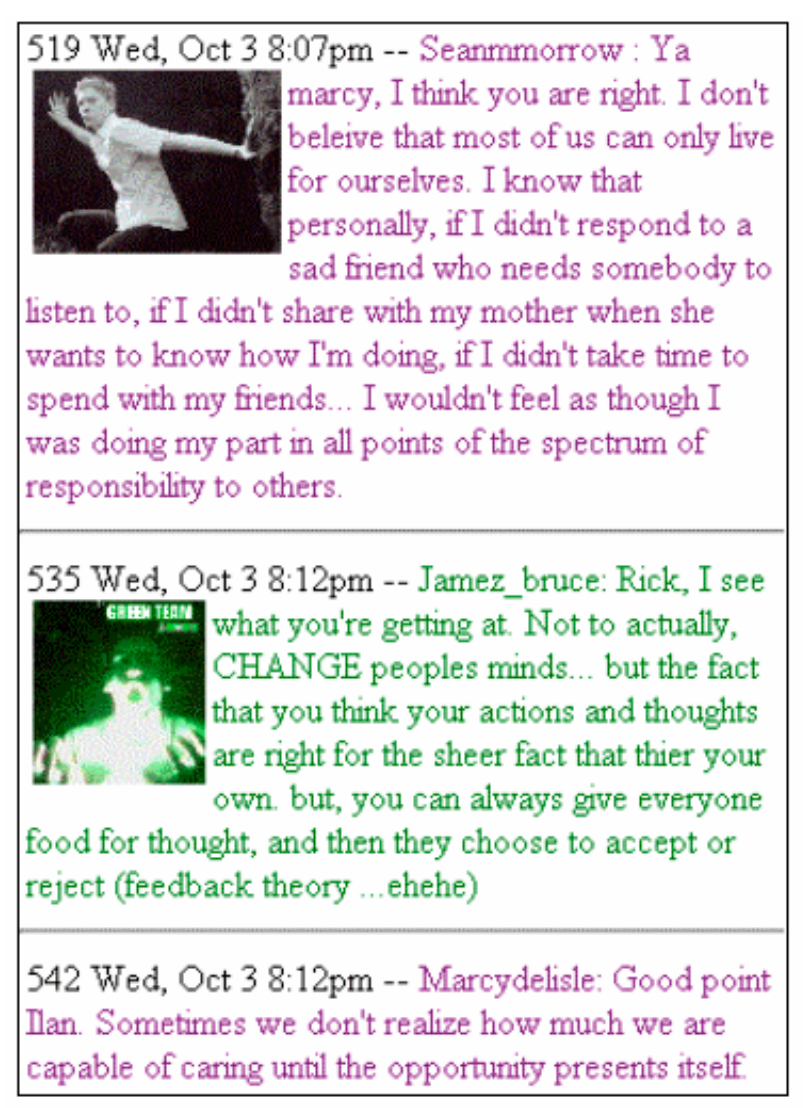
Reporting Back to the